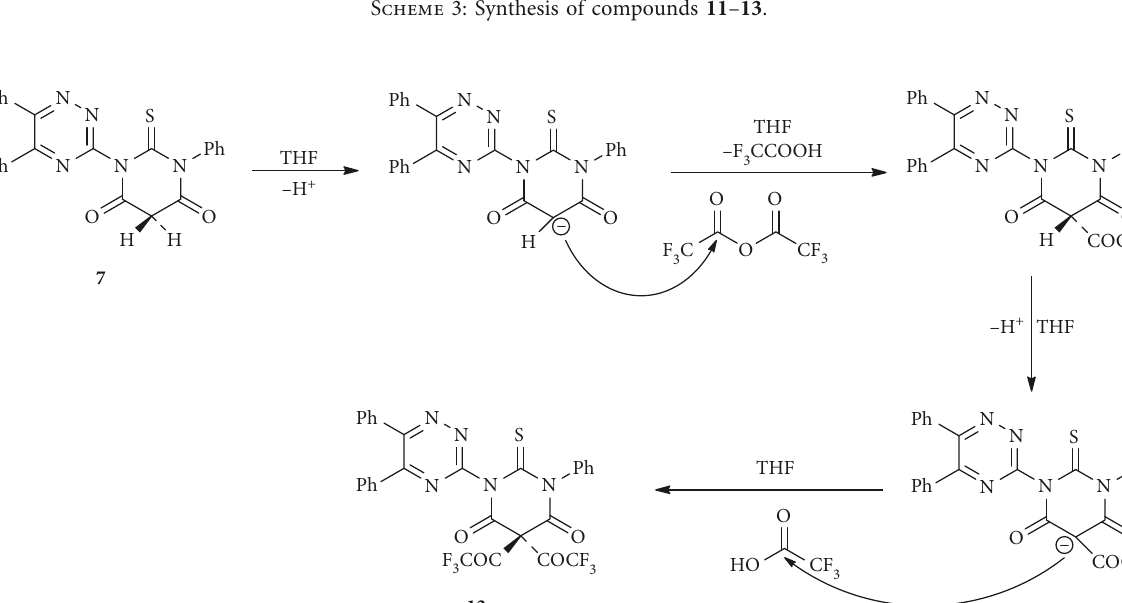
Scheme 3: Synthesis of compounds 11 – 13